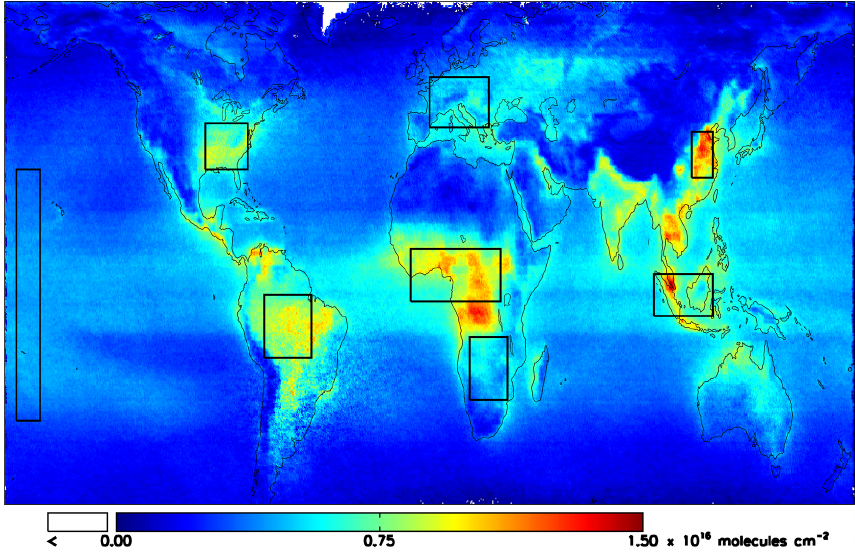
Figure 7. OMPS SAO H 2 CO (January through September 2013) global mean at a resolution of 0.25 ◦ × 0.25 ◦ showing the eight regions used in the comparison of OMPS SAO, OMI BIRA, and OMI SAO retrievals. Seven of these regions have enhanced H 2 CO concentrations linked to biogenic, anthropogenic, and biomass burning processes. The eighth region, the Pacific Ocean, shows background concentrations of H 2 CO due to CH 4 oxidation.